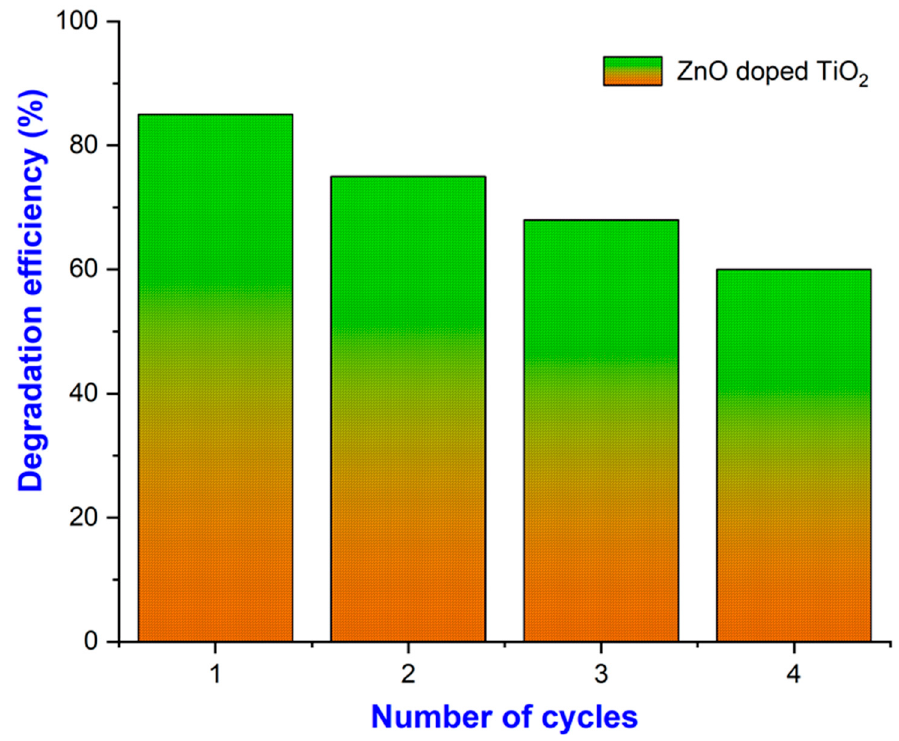
Figure 8. Photocatalytic degradation efficiency bar diagram of ZnO-doped TiO 2 nanocomposites.